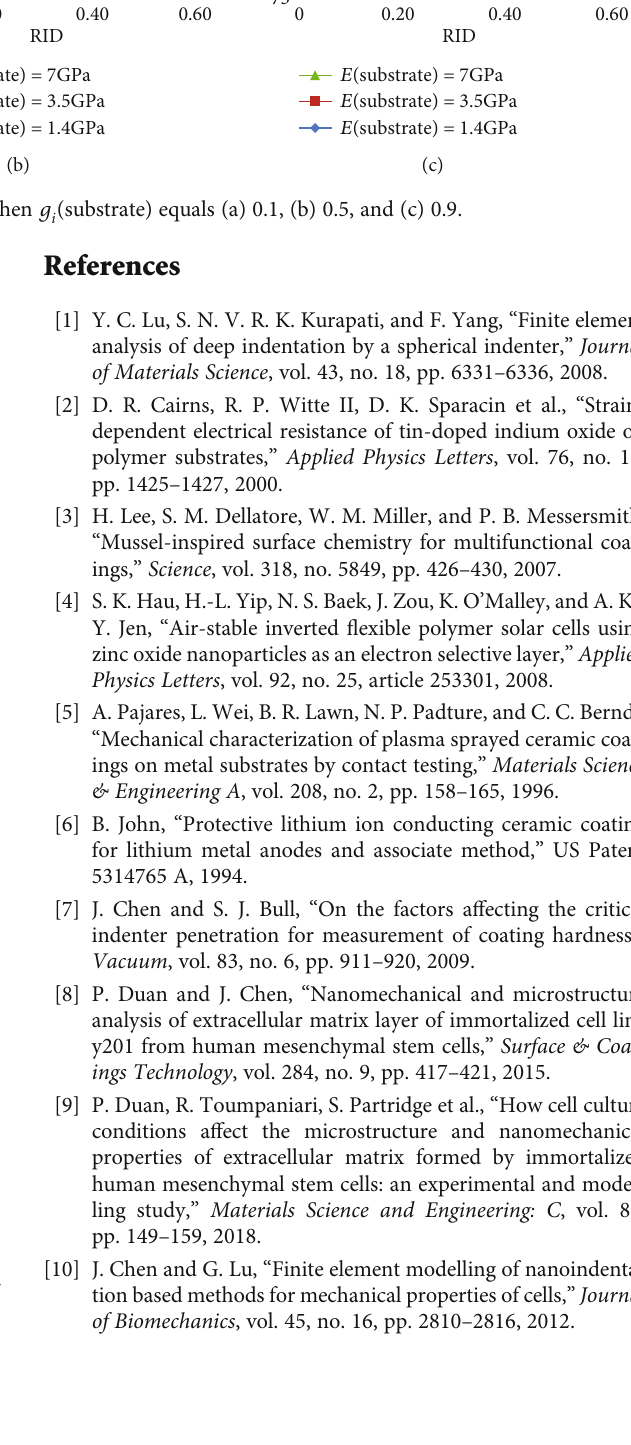
(substrate) equals (a) 0.1, (b) 0.5, and (c) i